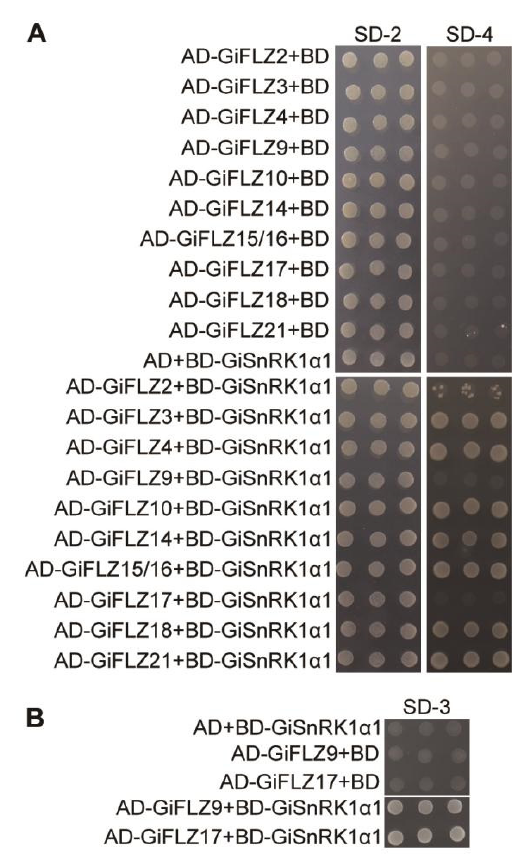
Figure 2. Ten selected GiFLZs interact with GiSnRK1 α 1 in yeast cells. ( A , B ) Interactions between GiSnRK1 α 1 and GiFLZs. GiFLZs were fused to the activation domain (AD), and GiSnRK1 α 1 was fused to the DNA-binding domain (BD), respectively. Co-transformed yeast clones were plated on SD/–Leu–Trp (SD-2), SD/–Leu–Trp–His-Ade (SD-4), or SD/–Leu–Trp–His (SD-3) plates to test the